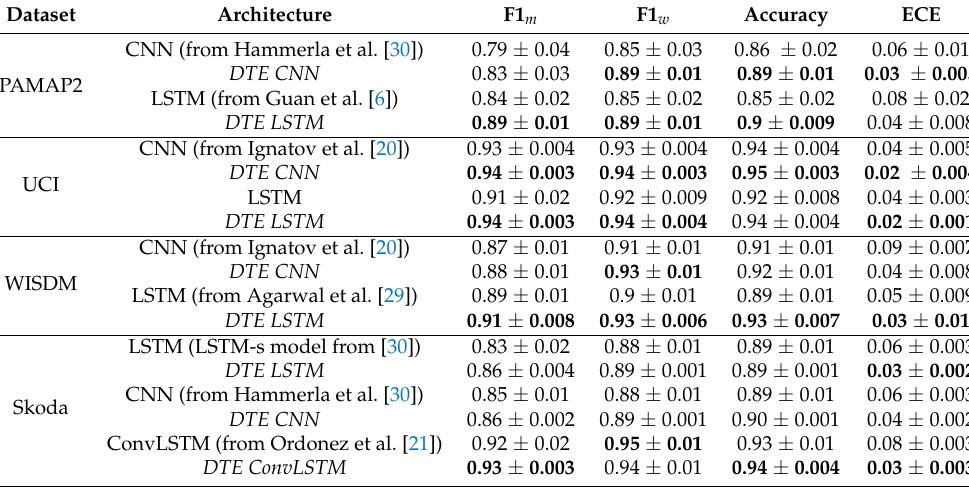
Table 3. Classification and calibration results (10 experiments per setting) for baseline architectures versus DTE (our method) across all